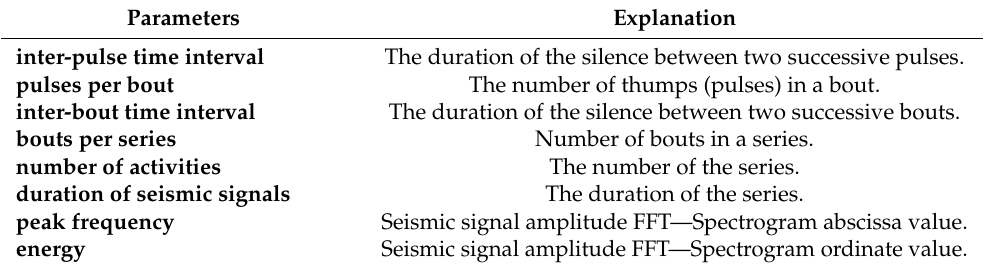
Table 1. Definition of measurement parameters related to seismic communication in the study. Parameters Explanation inter-pulse time interval The duration of the silence between two successive pulses. pulses per bout The number of thumps (pulses) in a bout. inter-bout time interval The duration of the silence between two successive bouts. bouts per series Number of bouts in a series. number of activities The number of the series. duration of seismic signals The duration of the series. peak